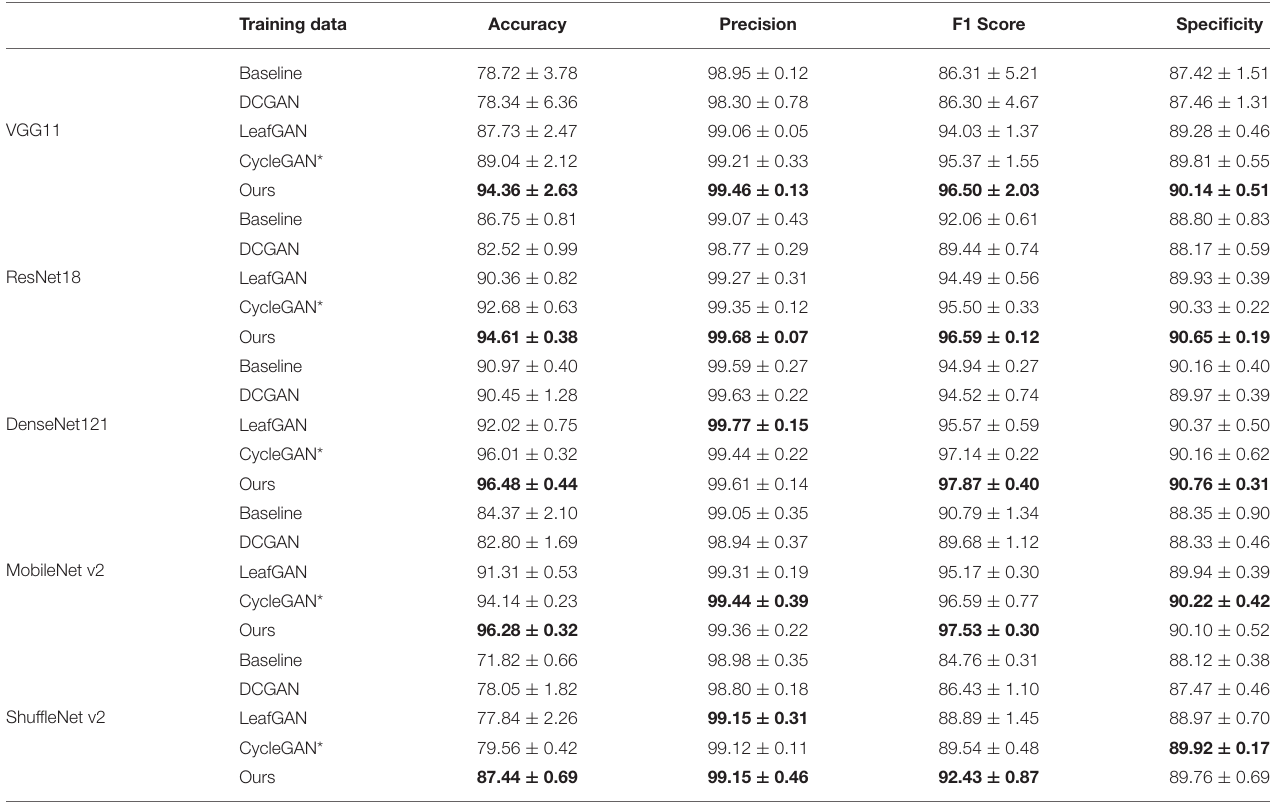
The boldfaces show the best average evaluation metric for each classification